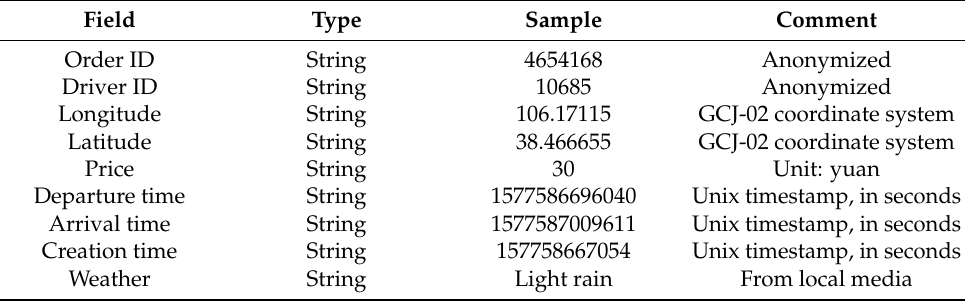
Figure 1. Study area. Table 1. Intercity ridesplitting data structure. Table 1. Intercity ridesplitting data